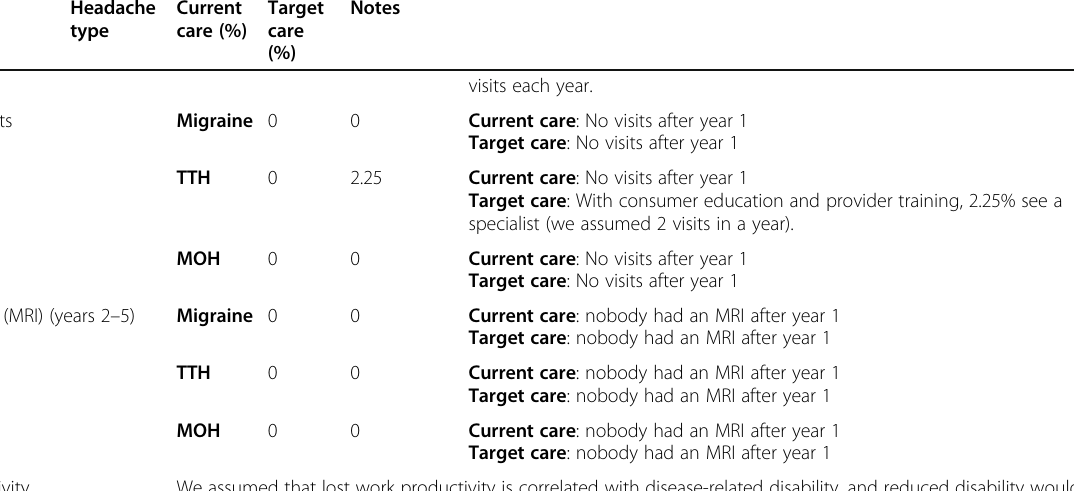
Table 3 Treatment uptake, use of resources and lost productivity according to treatment management plan (Spain)